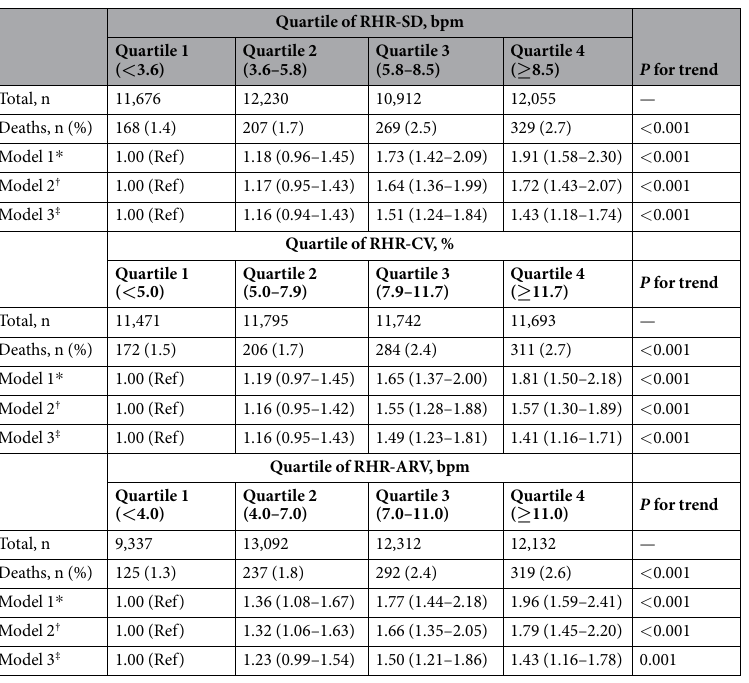
Table 3. Cumulative mortality and hazards ratios (95% confidence interval) for all-cause mortality associated with quartile of standard deviation (SD), coefficient of variation (CV), and average real variability (ARV) of resting heart rate (RHR). * Unadjusted model. † Adjusted for age and gender. ‡ Adjusted for age, gender, body mass index, current smoker, mean systolic blood pressure, mean resting heart rate, fasting plasma glucose, total cholesterol, high density lipoprotein, elevated C-reactive protein and ACE